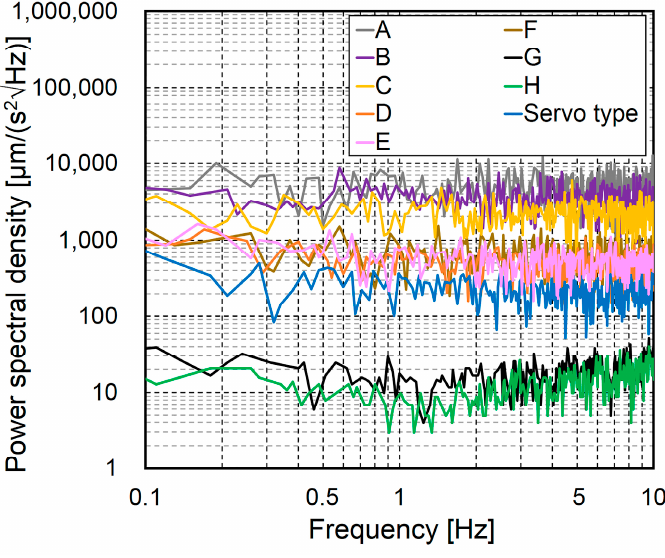
Figure 4. Static characteristics of accelerometers.